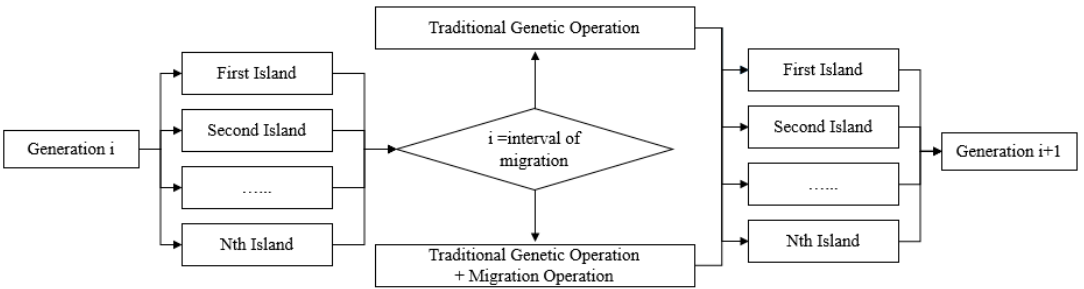
Figure 4. Process of multi-island genetic algorithm flow [15].